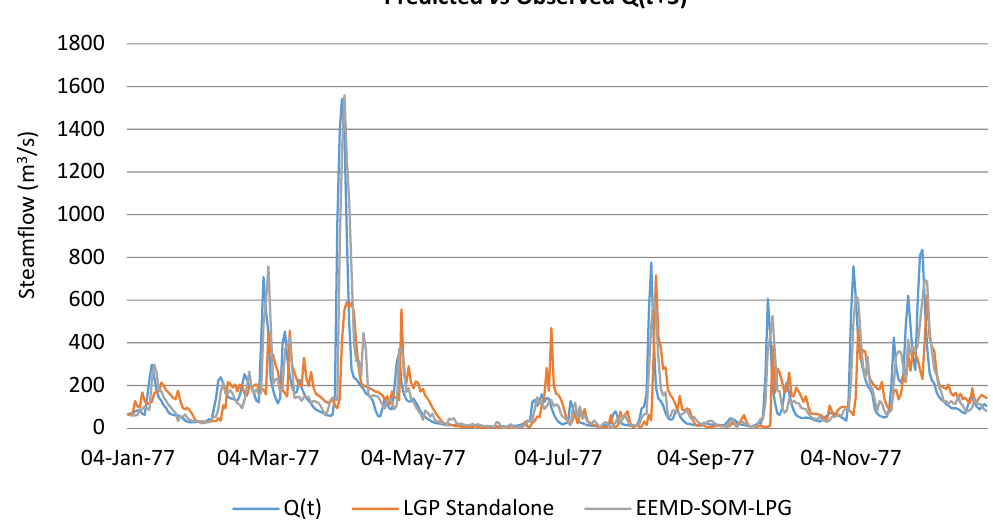
Figure 9. Scatter plots of observed vs. predicted for models in LGP-10. ( a ) Streamflow at 1 day ahead; Figure 8. Q( t +3) predicted vs observed for LGP-10 and LGP as a standalone. ( b ) streamflow at 2 days ahead; ( c ) streamflow at 3 days ahead; ( d ) streamflow at 4 days